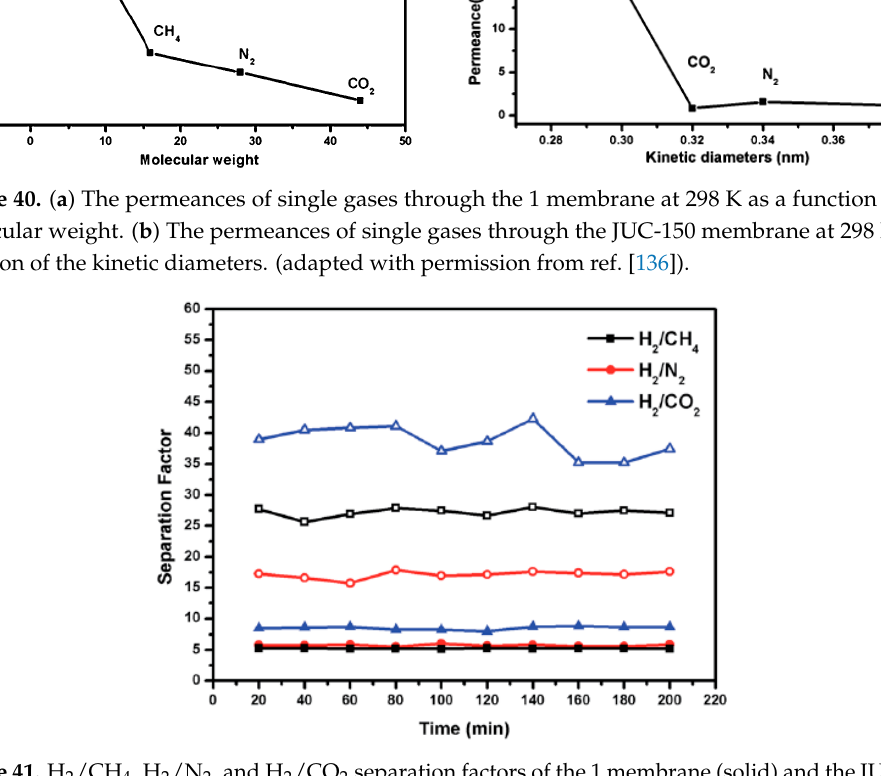
Figure 41. H 2 /CH 4 , H 2 /N 2 , and H 2 /CO 2 separation factors of the 1 membrane (solid) and the JUC-150 membrane (hollow) over time (adapted with permission from ref. [136]).